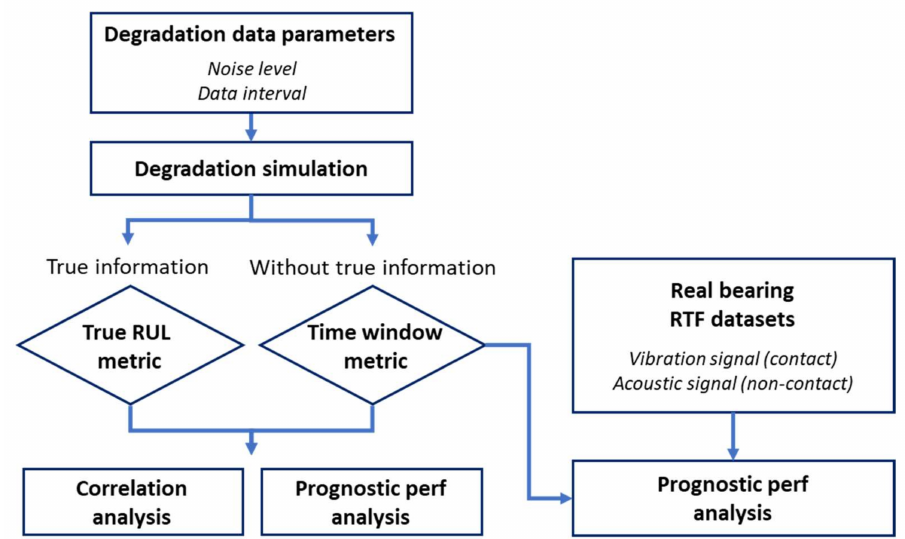
Figure 1. The overall framework of the sensor